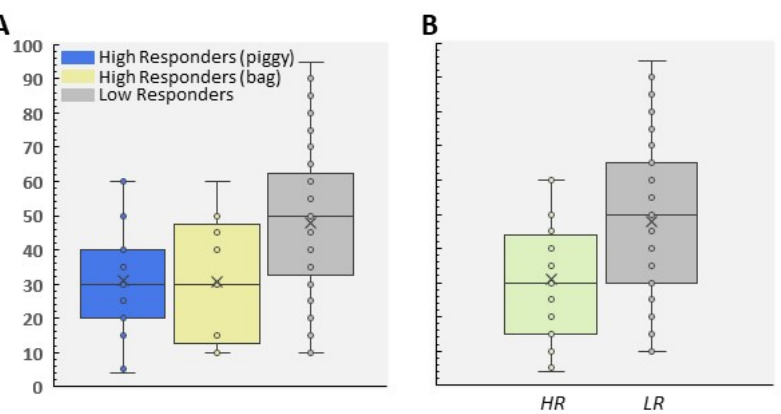
Figure 5. ( A ) Mean percentile of attention distributed by HR to the piggy, to the bag, and LR. ( B ) Score in the LR and pooled HR groups.